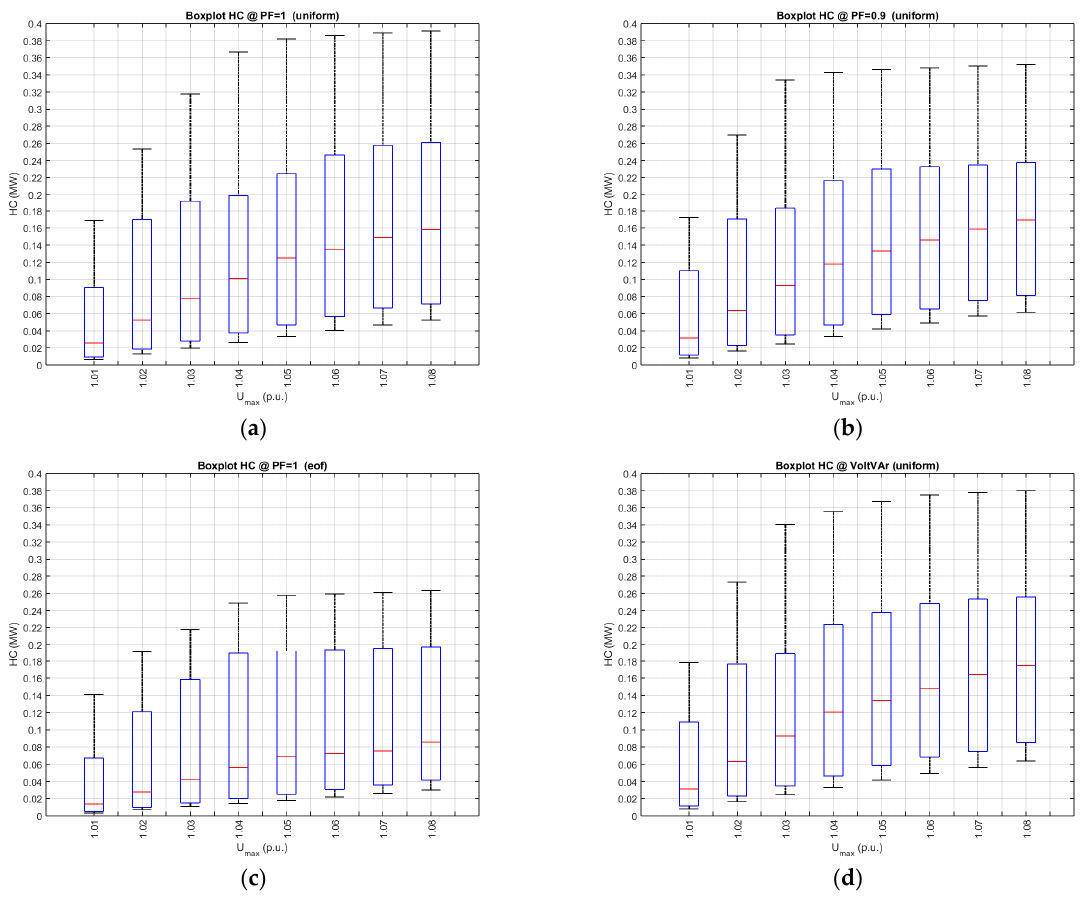
Figure 18. Hosting Capability results of selected scenarios: ( a ) DER-scenario uniform, PF = 1; ( b ) DER-scenario uniform, PF = 0.9; ( c ) DER-scenario eof, PF = 1; and ( d ) DER-scenario uniform, VoltVAr [37].